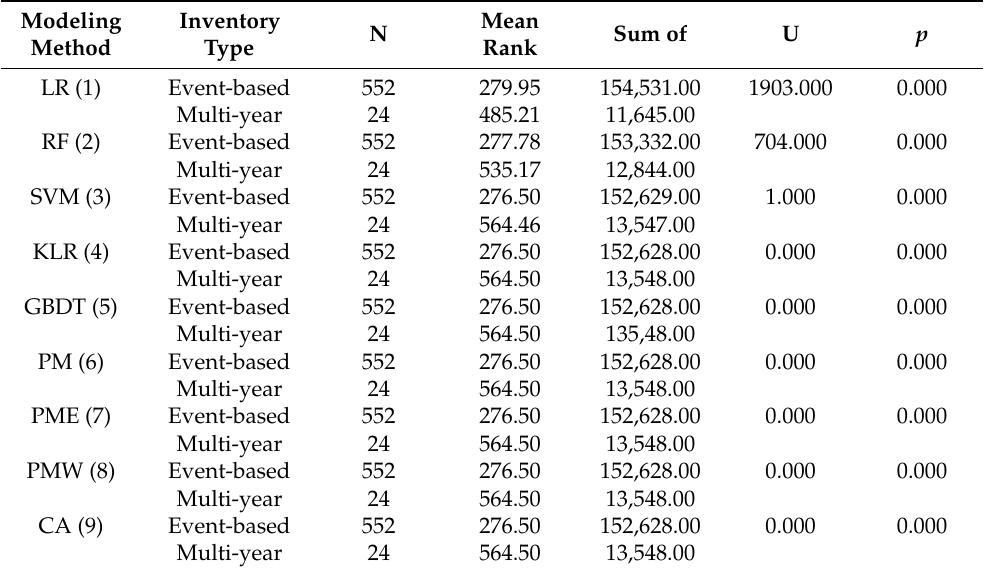
Table 12. Mann–Whitney U test of the predictive accuracy of models, based on different types of landslide